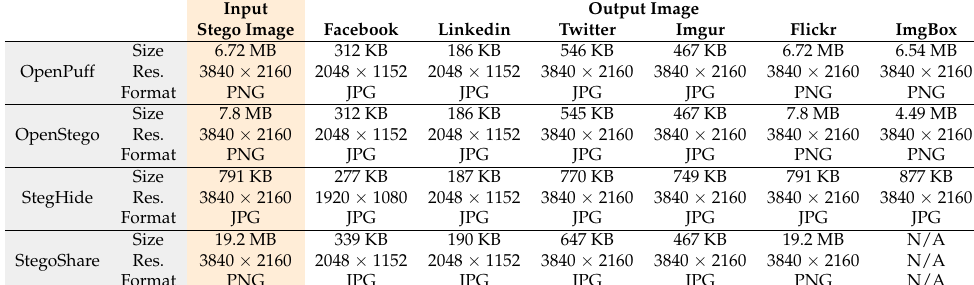
Table 3. Results of the first test.